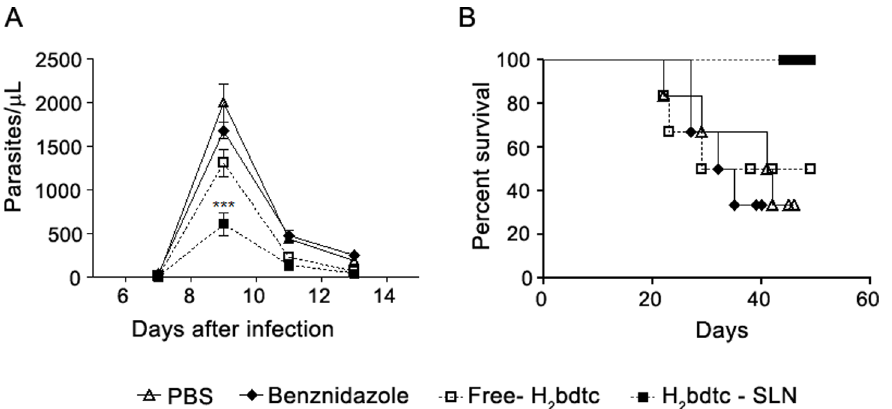
Figure 4. Parasitaemia and survival rates of mice infected with T. cruzi and treated with free H2bdtc, H2bdtc encapsulated in SLNs and BZN. (A) Parasitaemia was monitored on days 7, 9, 11 and 13 after infection. (B) Survival was monitored daily for 60 consecutive days. The mean + SEM is shown and is representative of three independent experiments (n=7). Statistically significant differences compared with the control (BZN). T student test: ***p , 0.001